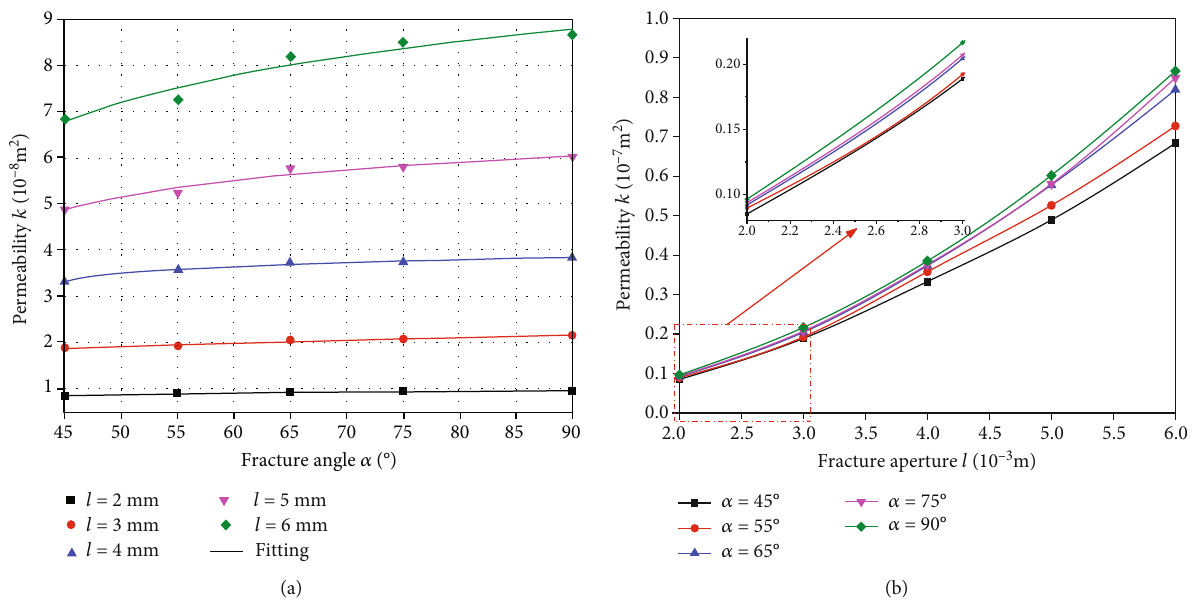
Figure 9: In fl uence of fracture angle on fracture permeability: (a) fracture angle; (b) fracture aperture. Table 3: Fitting parameters for Equation